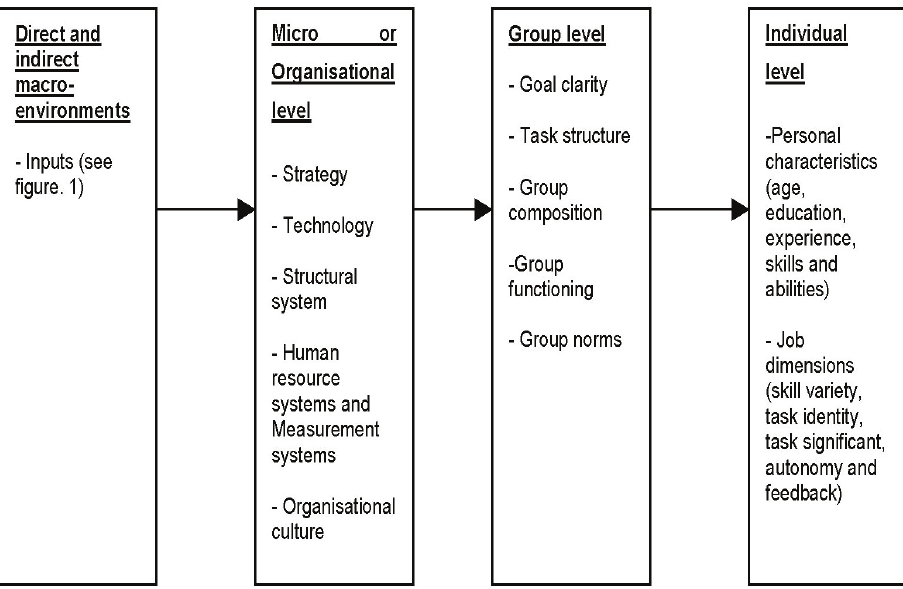
Figure 2: Conceptual Model of analytical issues when bringing change in municipalities